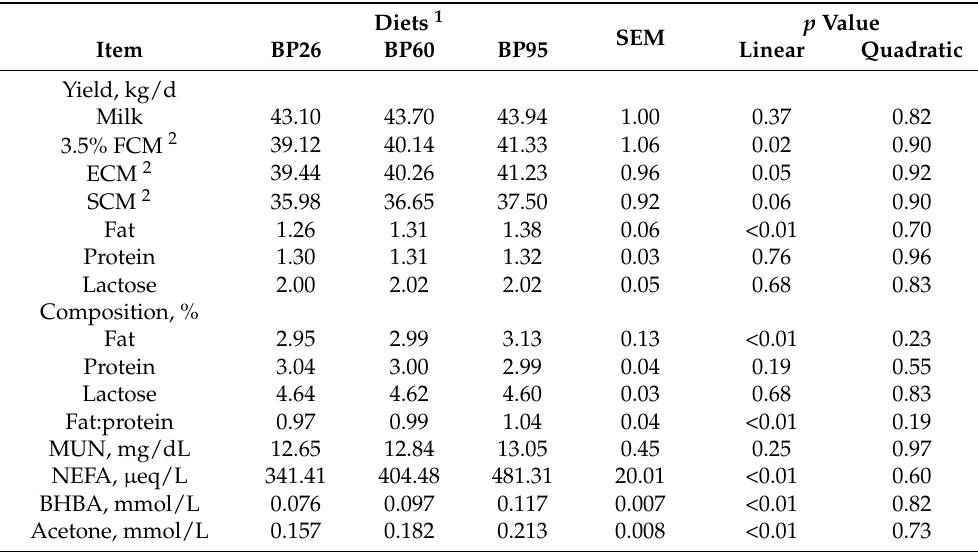
Table 6. Effect of replacing human-edible feed ingredients with byproducts on lactation performance.